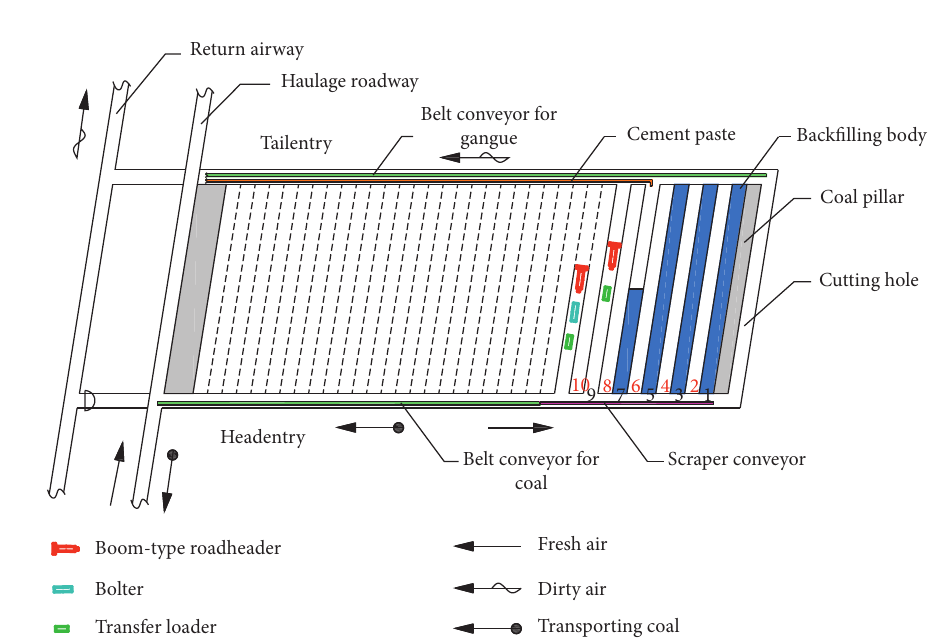
Figure 2: Schematic diagram of the working face layout.